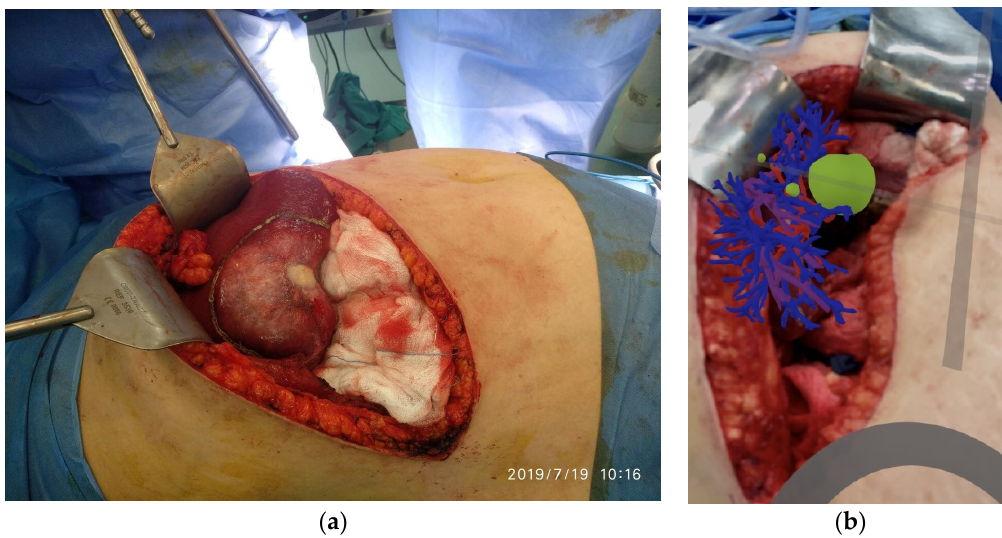
Figure 5. Surgery and augmentation. Position of the tumor as shown before the resection ( a ) and augmentation of the model using an iPhone camera ( b ). The research protocol and the study were approved by the Investigational Review Board (IRB) of the hospital where the research was conducted. Informed consent was obtained from the patient before the realization of the surgery.